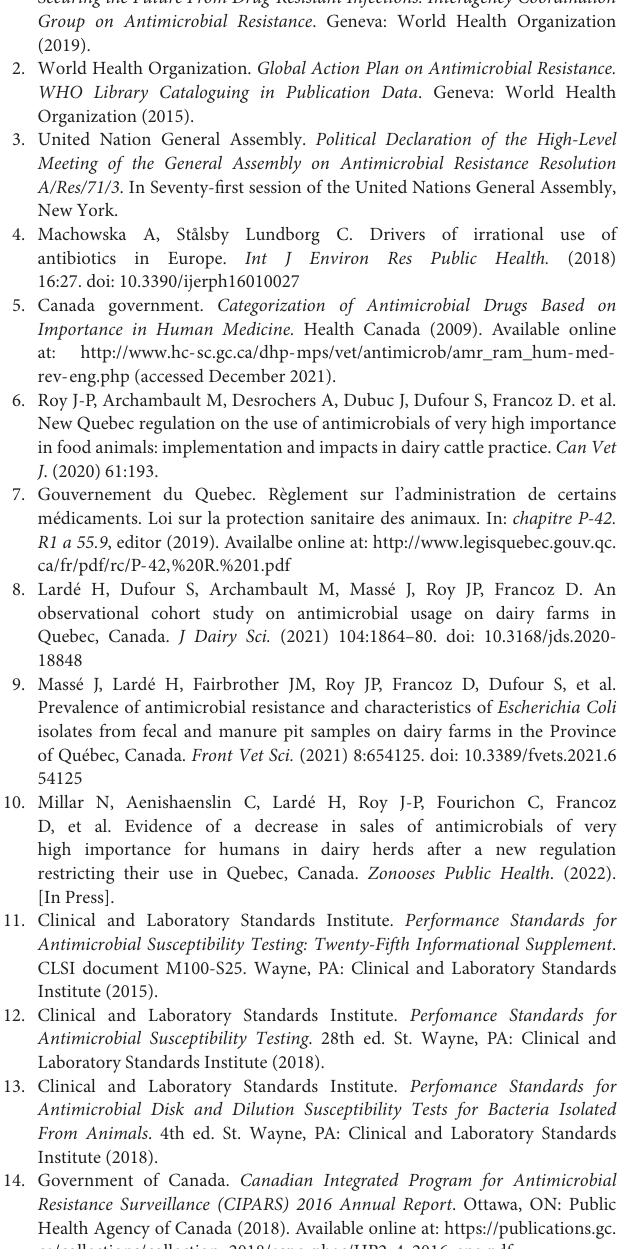
regulation implementation. (A) Comparison between spring 1 (pre) and spring 2 (post) regulation. (B) Comparison between fall 1 (pre) and fall 2 (post) regulation. No significant differences were identified between groups. Supplementary Table S1 | Quality of assembly data of whole genome sequencing of isolates from the generic collection ( n = 15) from calf or cow feces or manure pit of 87 dairy farms in Québec, Canada in